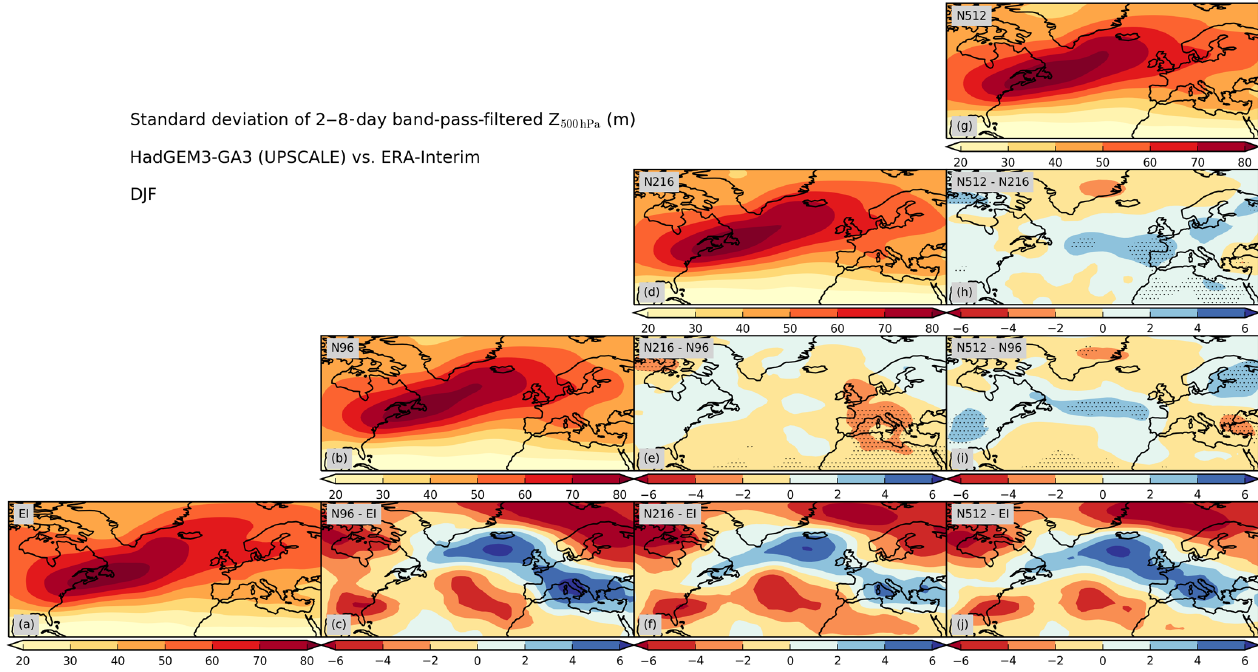
Figure 7. Standard deviation of 2–8-day band-pass-filtered 500hPa geopotential height (m). (a) ERA-Interim reanalysis, (b, d, g) model (HadGEM3-GA3) at resolutions N96, N216, and N512, (c, f, j) model biases with respect to ERA-Interim, and (e, h, i) differences between model resolutions. Stippling shows statistically significant